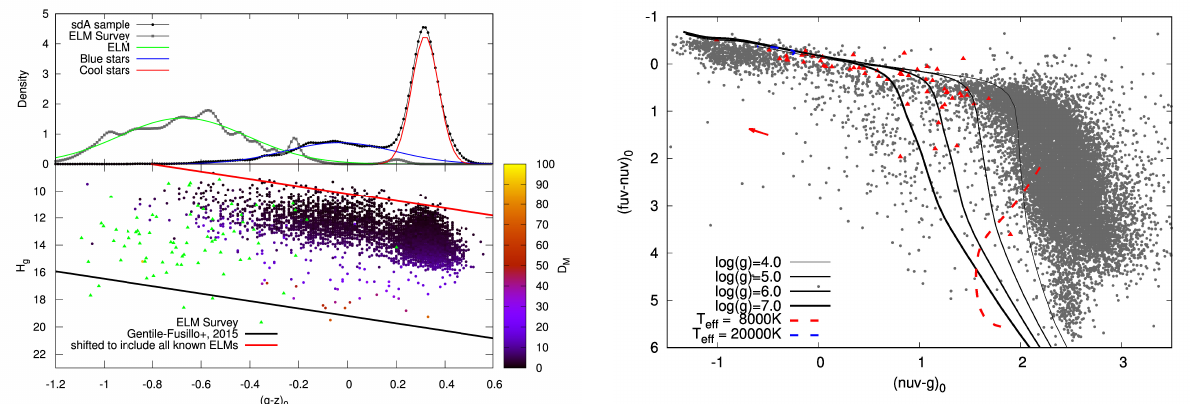
Figure 7. H g × ( g − z ) 0 diagram (see e.g. Gentile-Fusillo et al. 2015), with the objects in sample B colour coded according to their Ma- halonobis distance to the halo given a main sequence radius. Known ELMs are shown as green triangles for comparison. The top plot shows the densities assuming each object as a Gaussian to account for the uncertainty; it becomes clear that there are two pop- ulations of objects within the sdA sample. The suggested limit for white dwarf detection with probability equal to 1.0 given by Gentile- Fusillo et al. (2015) is indicated as a black solid line. Most known ELMs, due to their larger radius implying a smaller reduced proper motion, since they can be detected at larger distances, are not be- low the white dwarf limit. A reference line, dislocating the white dwarf limit to include all known ELMs is shown as a red dashed line. Most O, B and A stars are also below such line.